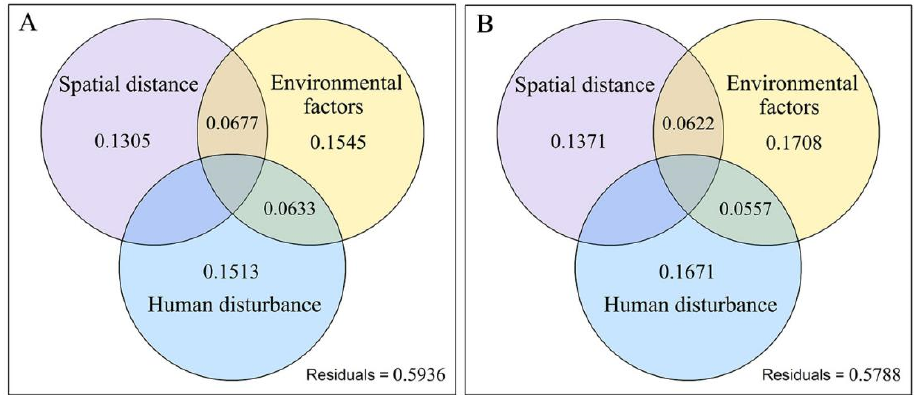
Figure 7. Main drivers of plant diversity in the seven nature reserves of the Yellow River in Henan Province, China. ( A , B ) Variance partitioning for the effects of spatial distance, environmental factors, and human disturbance on the beta diversity ( β j and β s) of wetland plants in the nature reserves. Values less than zero are not shown. Spatial distance: longitude, latitude. Environmental factors: ele- vation, precipitation, evaporation, temperature. Human disturbance: population density, industrial output value, agricultural output